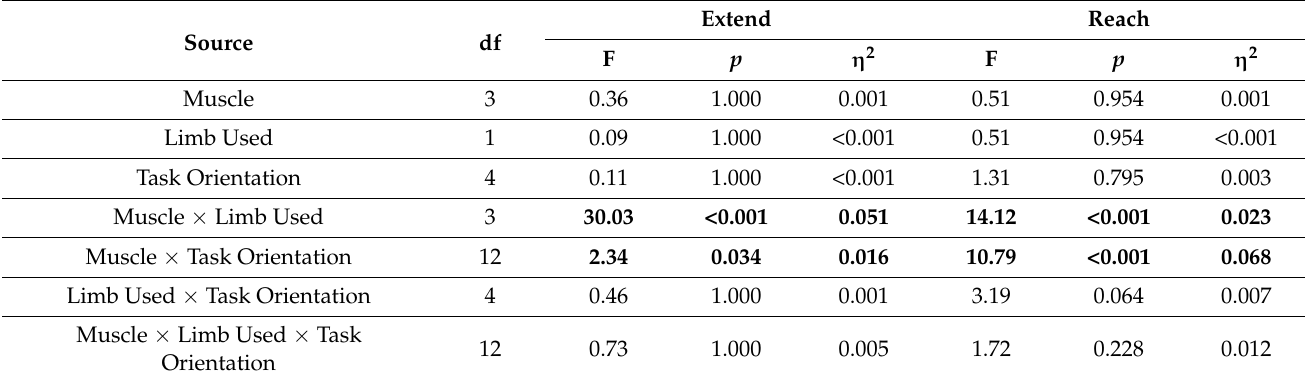
Table 1. Summary of ANOVA results regarding main and interaction effects of Muscle, Limb Used, and Task Orientation factors on Extend and Reach stages’ muscle activity. F statistic, p -value, and effect size are given, and statistically significant results are